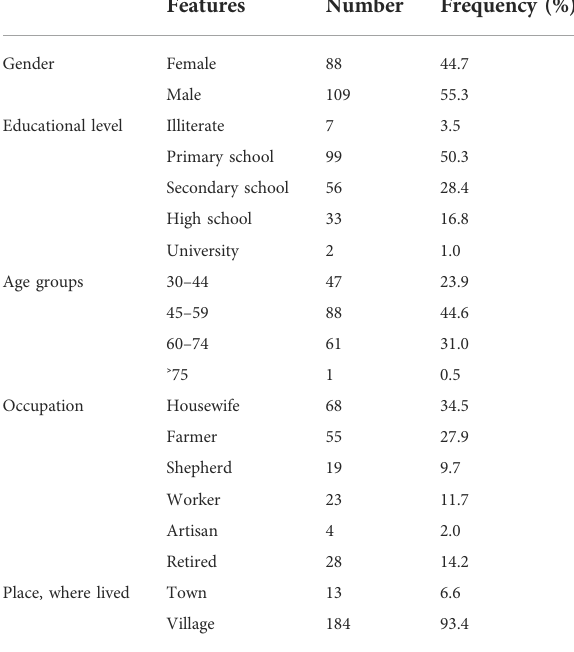
TABLE 3 Demographic characteristics of the informants ( n =